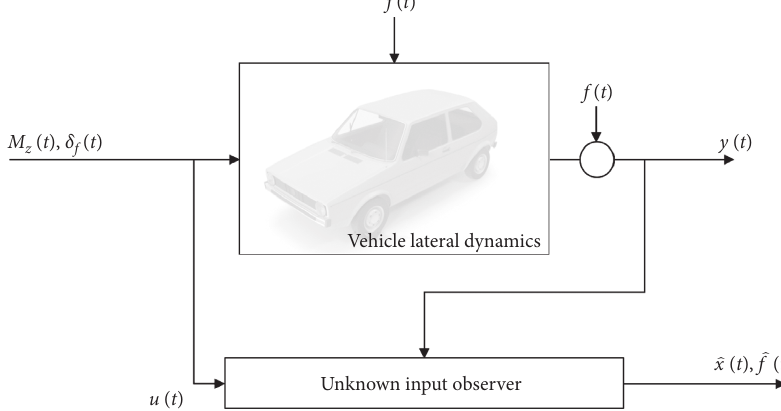
Figure 2: Observation